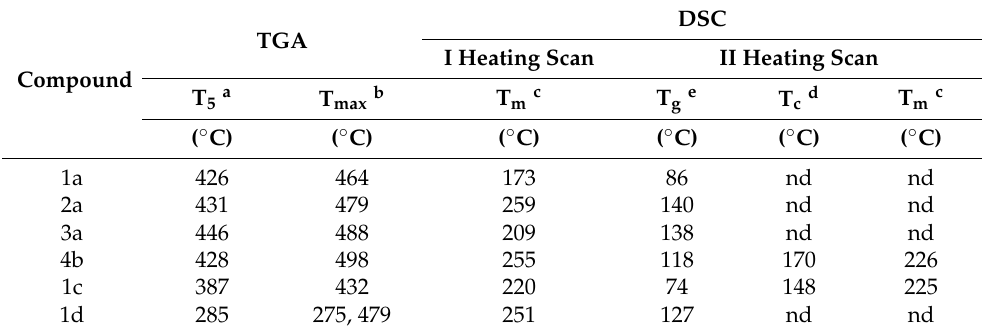
Table 2. Thermal stability and transition temperatures of investigated 1,8-naphthalimide derivatives.